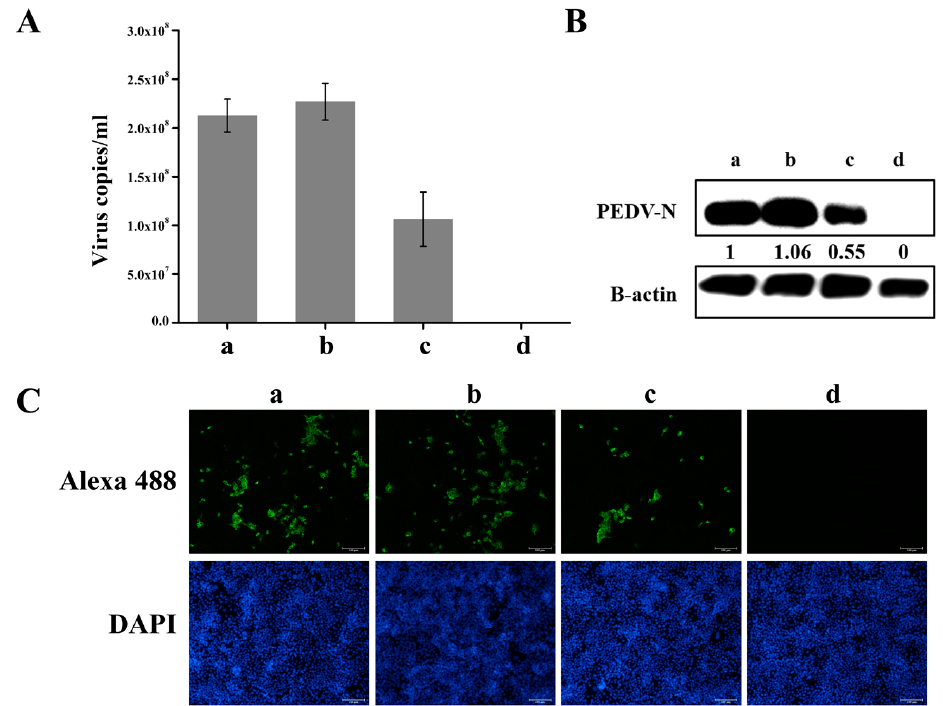
Figure 6. Knockdown of hnRNP A1 expression inhibits YN13 replication. CCL-81 cells were transfected without siRNA (a) or with NC (b) or siRNA-1 (c). At 60 hpt, cells were infected with YN13